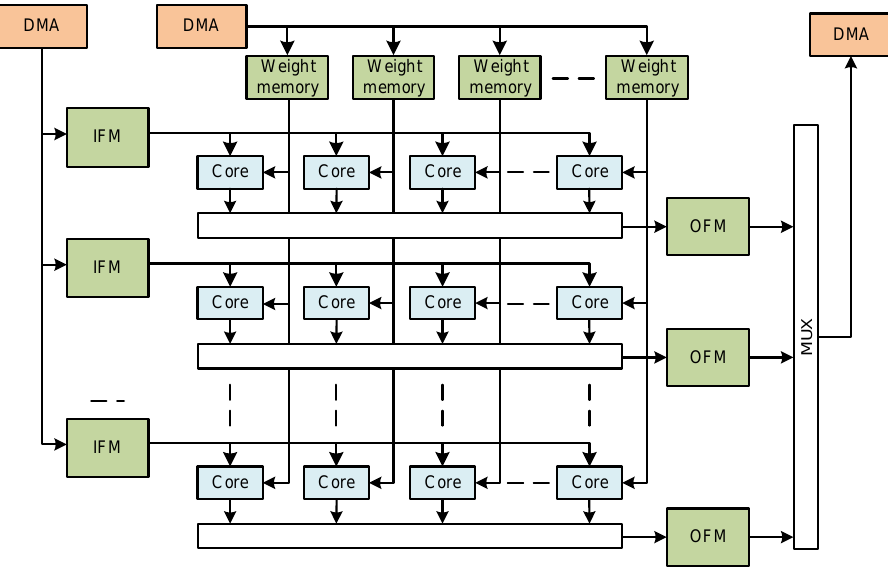
Figure 2. Block diagram of the proposed accelerator of the CNN network of